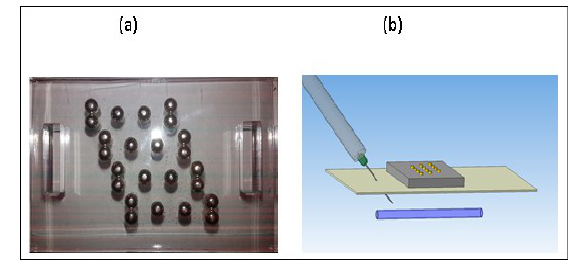
Fig. 2: a) The electrode system. b) The location of electrode system with respect to the vein.